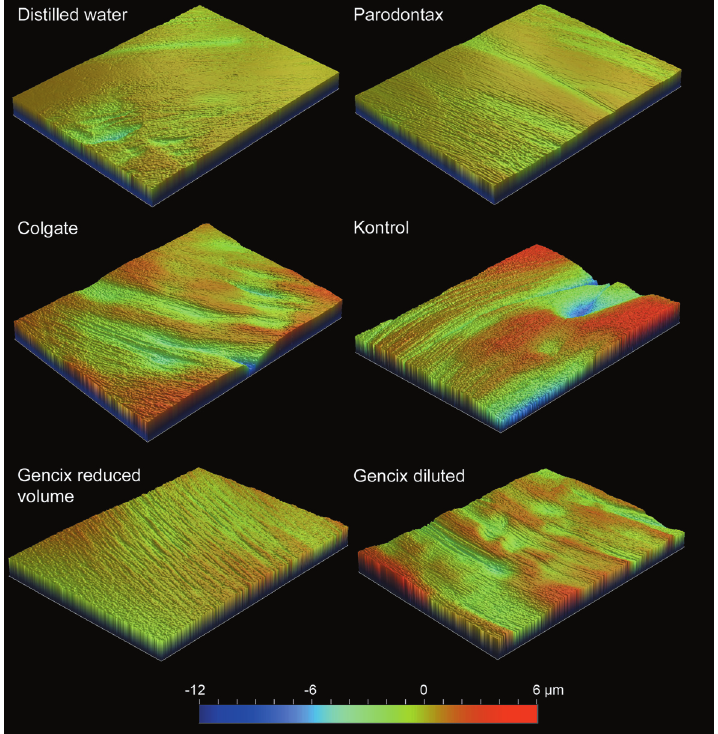
Figure 4- Vertical scanning interference microscopy of the surface of PMMA blocks after brushing with different types of dentifrices. Each image corresponds to a 1x1.3 mm surface area. The colored scale bar (ranging from -12 to +6 µm) represents the abrasion